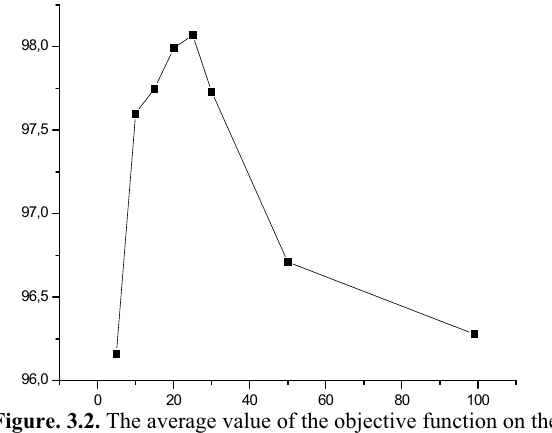
Figure. 3.2. The average value of the objective function on the size of the population